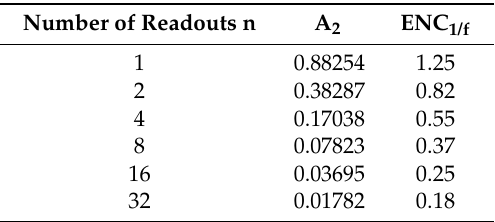
Table 1. 1/f filter coefficients for a saw-tooth weighting functions composed of n triangles. The corresponding ENC due to the 1/f noise is calculated assuming a f = 4.5 ˆ 10 ´ 12 V 2 /Hz and an DEPFET input capacitance of 40